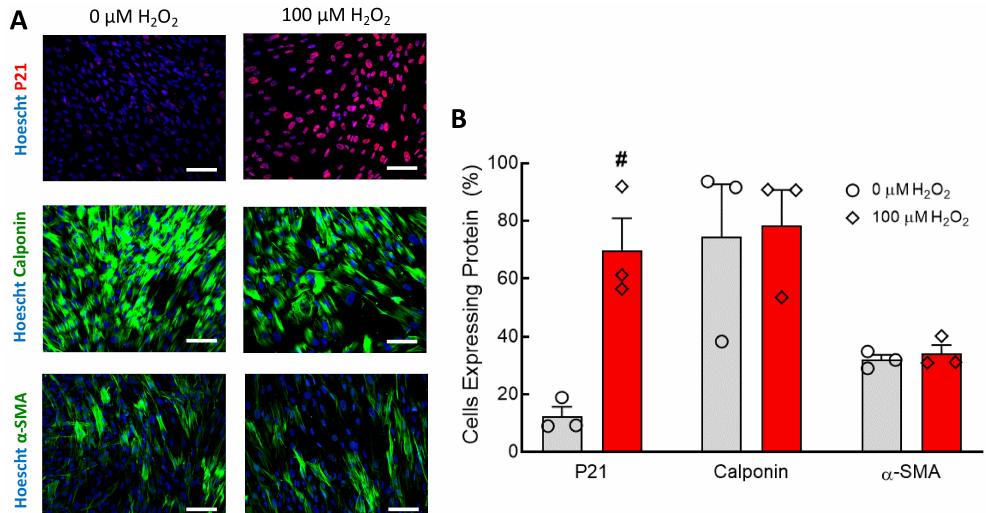
Figure 3. Seven-day 100 µ M H 2 O 2 treatment increased senescence in hNDFs but did not a ff ect contractile protein expression. ( A ) hNDFs were stained for P21, Calponin, and α -SMA. P21 expression was higher in hNDFs treated with 100 µ M H 2 O 2 . Scale bars represent 100 µ m. ( B )